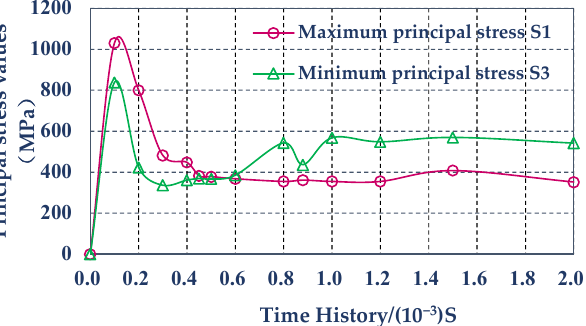
Figure 9. The absolute value of principal stress evolution law after blasting. From the initiation of the explosive to the time of 0.1 × 10 −3 s, the maximum principal stress S 1 and the minimum principal stress S 3 gradually increase, which is caused by the explosion. The S 1 stress induced by blasting is 1030 MPa and reaches the maximum value at the time of 0.1 × 10 −3 s, and the S 3 stress is 886 MPa. The surrounding rock is sandy mudstone with a compressive strength of 24.7 MPa, and it is damaged by the action of the blasting stress based on the maximum tension theory. The S 1 stress and the S 3 stress gradually decrease from the time of 0.1 × 10 − 3 s to 0.4 × 10 − 3 s. The S 1 stress tends to be stable, but the S 3 stress increases and the value is greater than that of the S 1 stress until the time of 0.6 × 10 − 3 s. Lastly, the S 3 stress tends to be stable at the time of 1.0 × 10 − 3 s. The above blasting stress evolution law shows that the explosion pressure is released rapidly after value. However, the S 3 stress decreases after reaching the maximum value and then increases